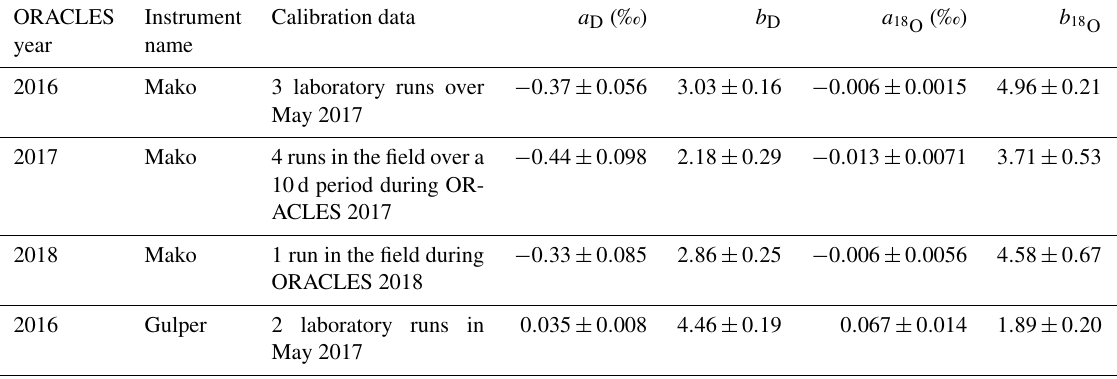
Table B1. Parameter values for Eq. (B2), the humidity-dependent bias correction in Picarro-measured isotope ratios, with standard errors. ORACLES